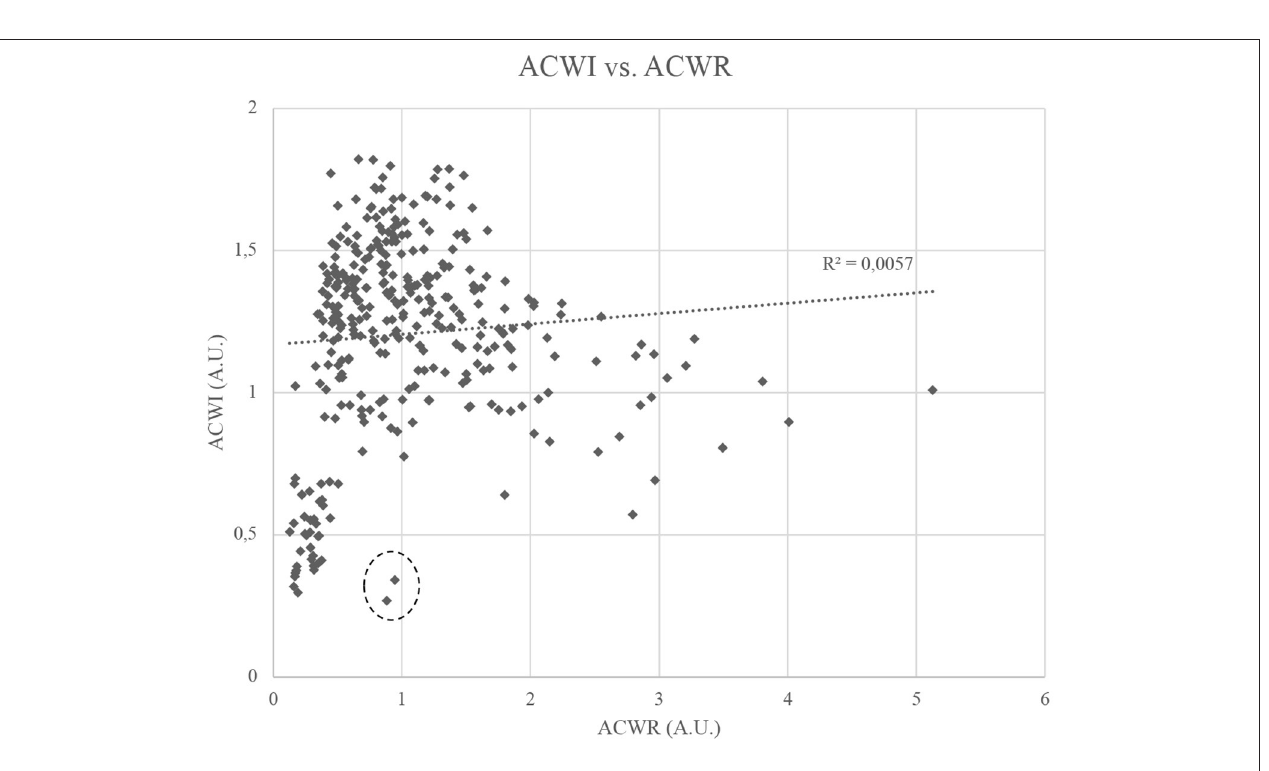
FIGURE 9 | Relationship between Acute:Chronic Workload Ratio (exponentially weighted moving average) (ACWR-EWMA) and Acute:Chronic Workload Index (ACWI). A.U., Arbitrary